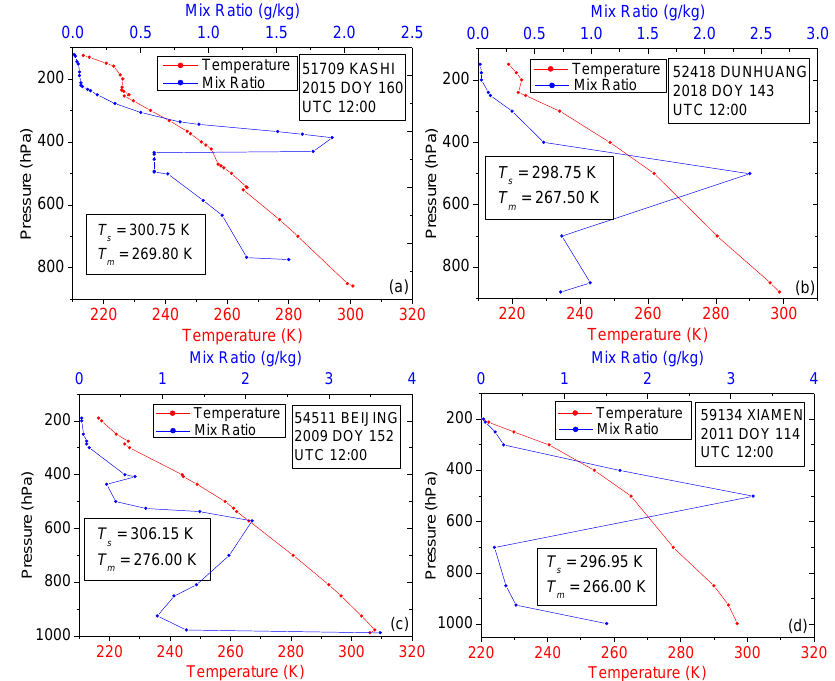
Figure 14. Representative vertical profiles of temperature (red) and water vapor mixing ratio (blue) from radiosonde observations that satisfy T s − T m > 30 K at station ( a ) KASHI, ( b ) DUNHUANG, ( c ) BEIJING, and ( d ) XIAMEN. The radiosonde observing time as well as T s and T m are shown in each